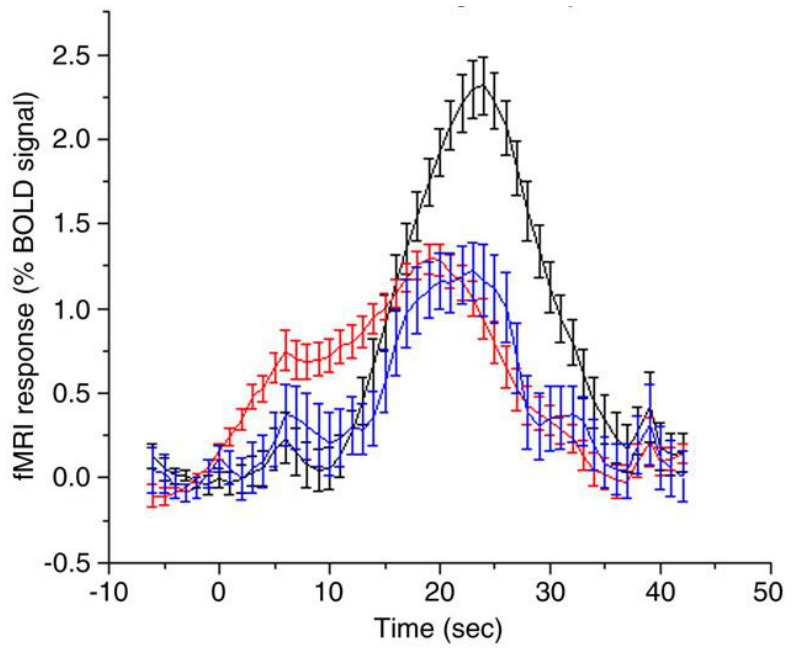
Figure 8. (Adapted from [23]) Averaged BOLD signal time-course with breath holding of 15 s after expiration on areas supplied by the MCA (red), ACA (blue), and PCA (black). Another significant difference between the long- and short-distance channels was the longer peak times of HHb responses in the short-distance channel (longer than BH duration, Table 1). The peak times of responses to BHs after expiration measured by hNIRS at 4 cm were close to those measured by BOLD fMRI in [26] (see Figure 2 in [26]). Our results show that without using a short-distance channel to remove biasing by the scalp, the cerebral responses to BHs were clearest in the rCCO time-course at 4 cm. Some features different from the scalp responses could also be seen in the HHb time-course at 4 cm. At 3 cm, some features of the cerebral response could be poorly recognized in the HHb time-course. The HbO 2 time-course did not show clear cerebral responses to BH at 3 cm or at 4 cm, in particular due to the high inter-subject variability. However, measurement of rCCO changes required hyperspectral or many-wavelength multispectral technology. We found the waveband 750–900 nm be optimal for the detection of cerebral responses to BHs in adults. The wavelength that exhibited the largest fractional change in the detected optical signal with respect to the baseline value both at 3 and 4 cm was between 800 and 850 nm, which was in good agreement with the results of [13] (830